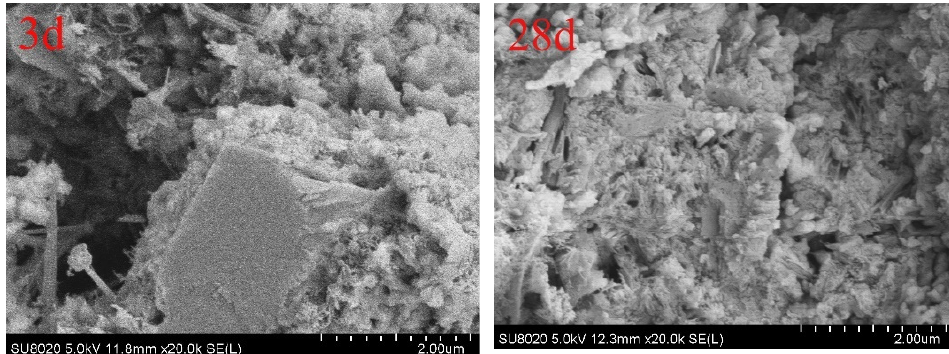
Figure 12. Results of the PM3 sample SEM of different ages.